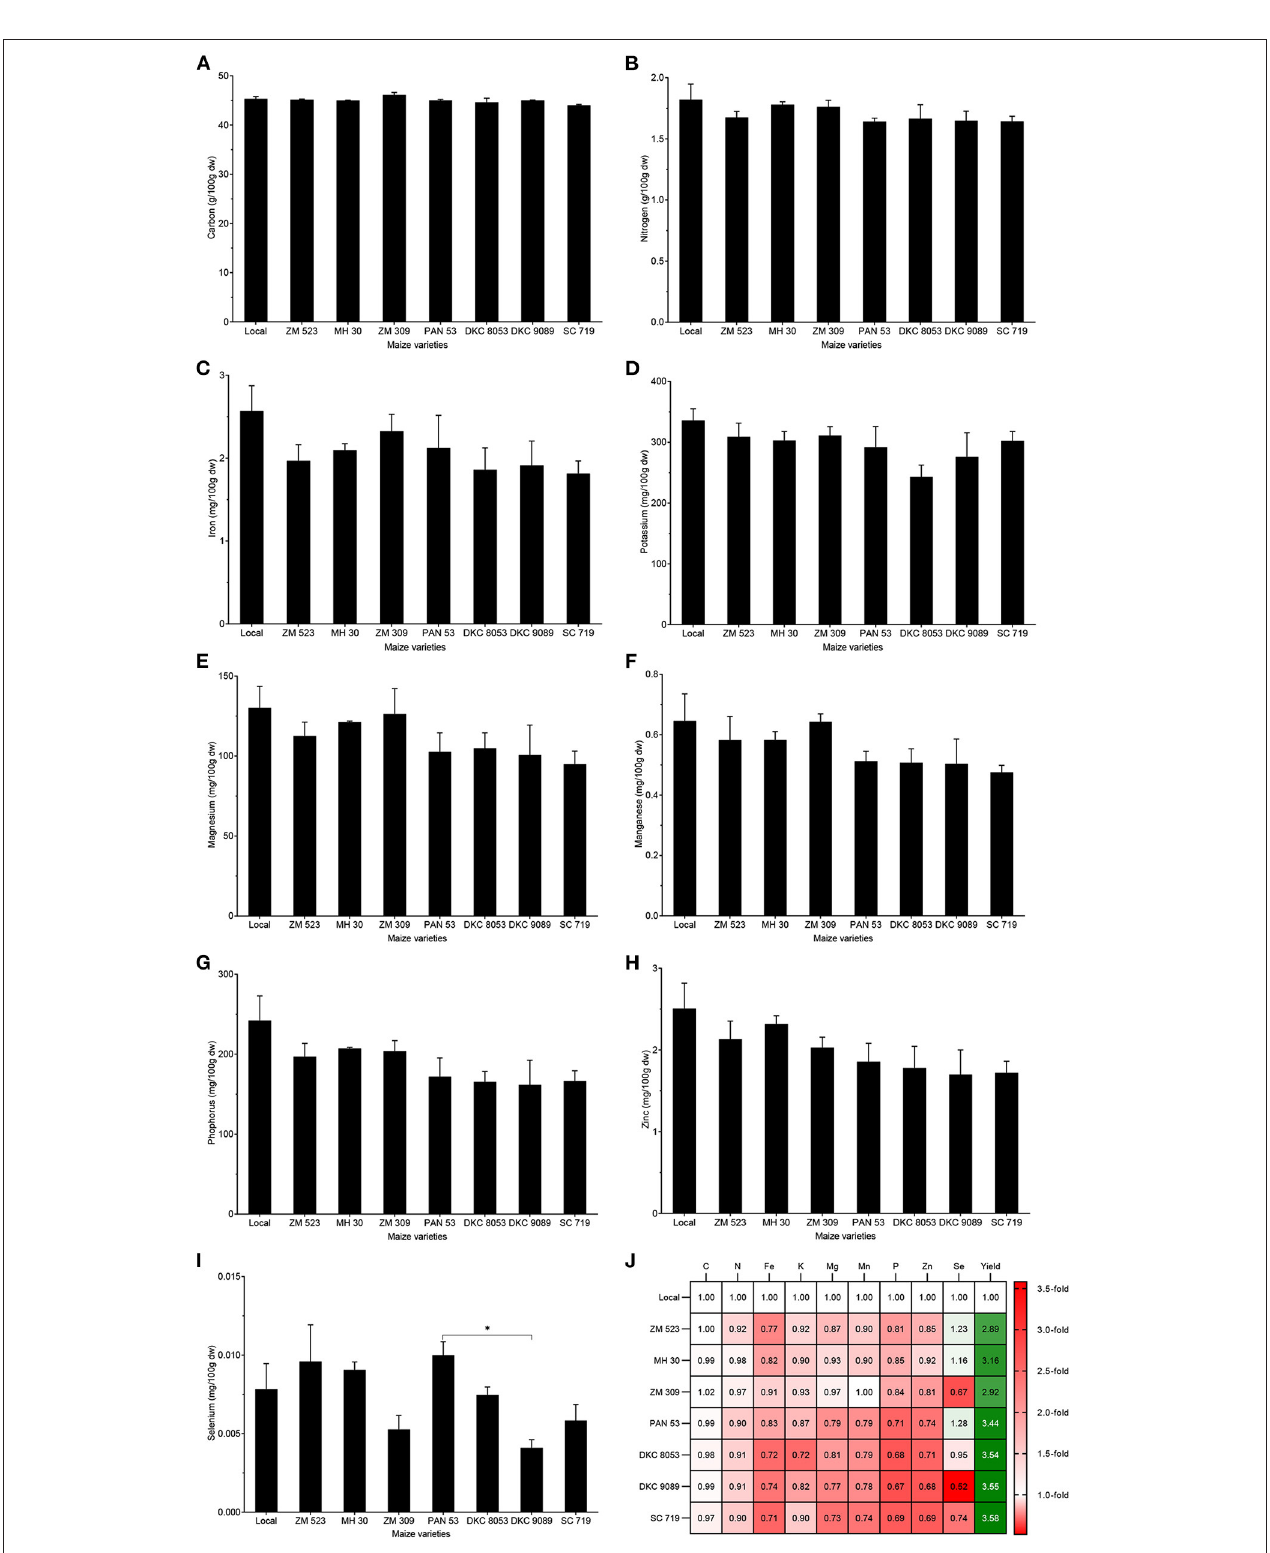
FIGURE 2 | Mineral content of eight maize varieties grown in Malawi. Error bars represent SEM. * means significant at 0.05, Tukey’s HSD test. Values in plate (J) are the number of fold-change compared to local variety.